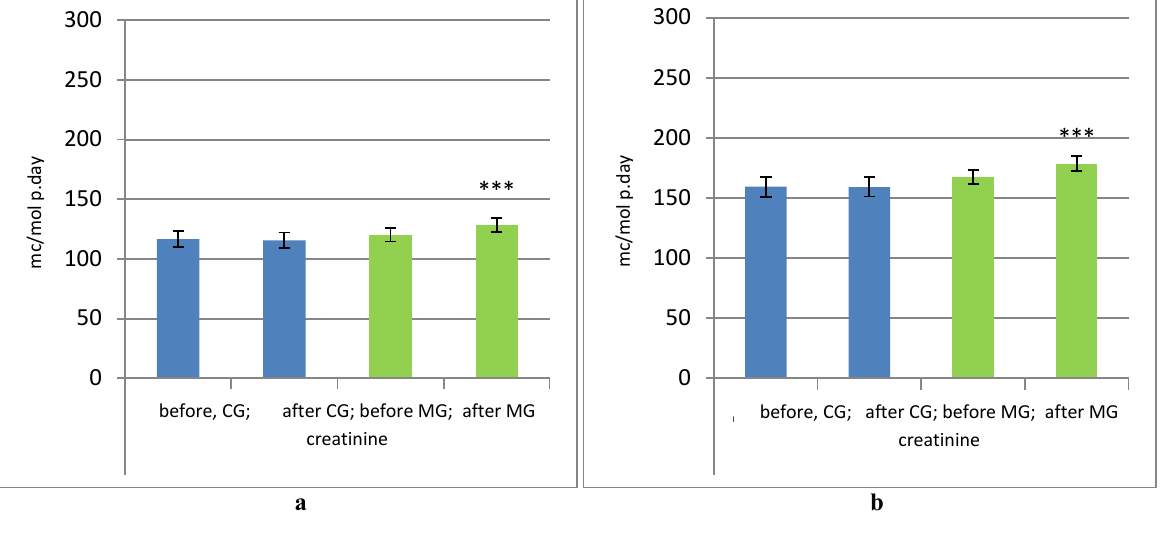
Fig.6 . Indicators of bio-chemical monitoring by excretion of creatinine before and after experiment in lactate cluster (of main and comparative groups): a) by bicycle stress test «Vita maxima»; b) by results of control special tests. (*** -р ≥ 0.001). CG – comparative group, MG – main